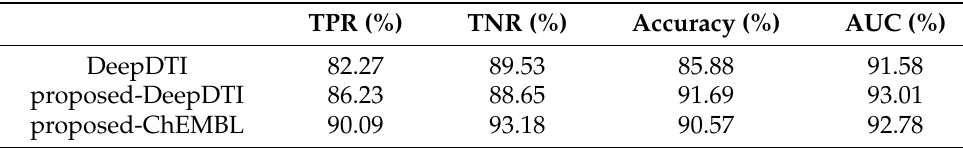
Table 5. Predictions on external validation